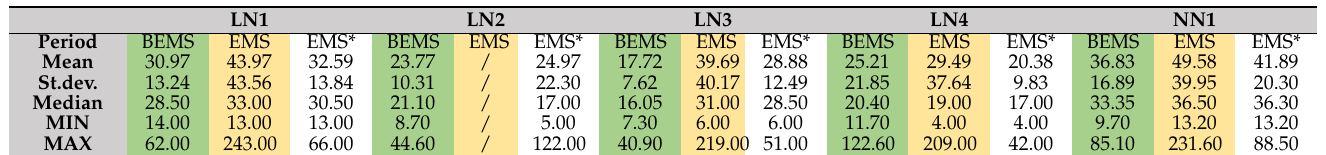
Table 1. Descriptive statistics for PM 10 [ µ g/m 3 ] data collected via the national and local network for air pollution monitoring in Novi Sad for the period of BEMS and EMS campaign in Novi Sad. EMS* denotes EMS data with Aralkum Desert episode excluded from data.